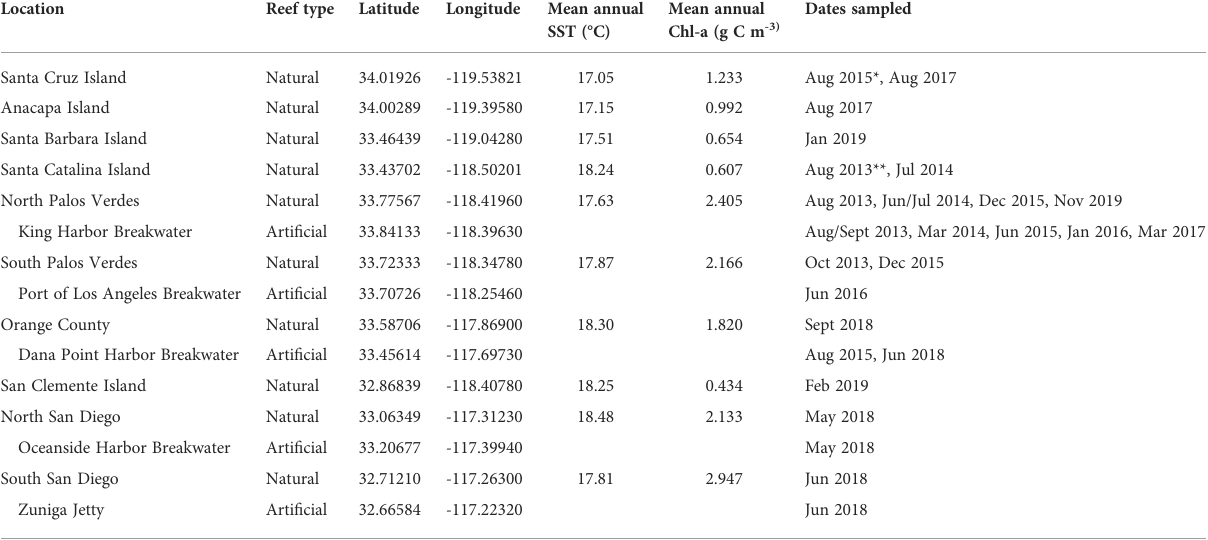
TABLE 1 Garibaldi ( Hypsypops rubicundus ) collection locations, environmental and geographic information including mean annual sea surface temperature (SST; °C) and mean annual Chlorophyll-a (Chl-a, g C m -3 ) from January 2002- December 2018.